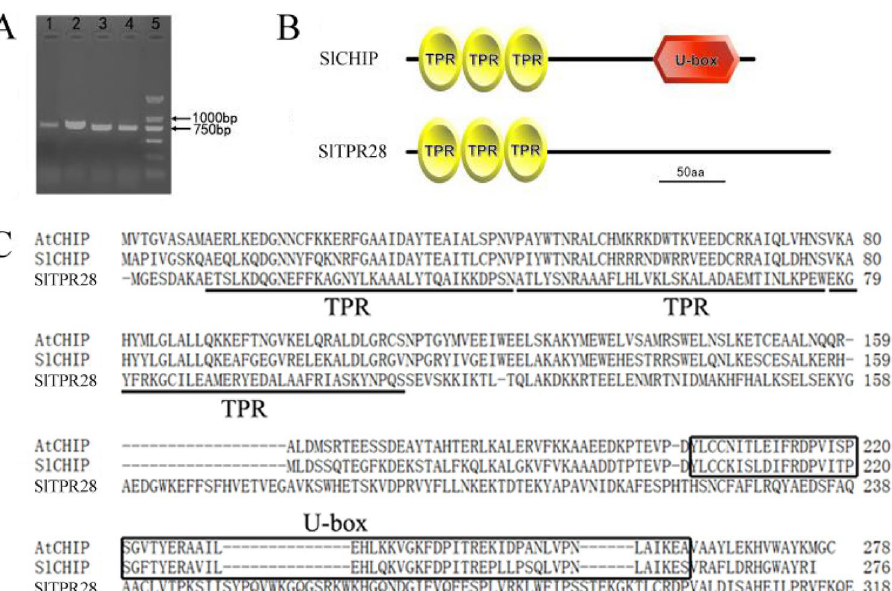
Figure 1. Tomato SlCHIP and SlTPR28 genes and encoded proteins. ( A ) PCR products of SlTPR28 (lanes 1 and 2) and SlCHIP (lanes 3 and 4) coding sequences. ( B ) The TPR motifs and U-box domain in predicted SlCHIP and SlTPR28 proteins. ( C ) Alignment of protein sequences of AtCHIP, SlCHIP and SlTPR28. The three TPR motifs were underlined and the U-box domain was highlighted by a rectangular box.